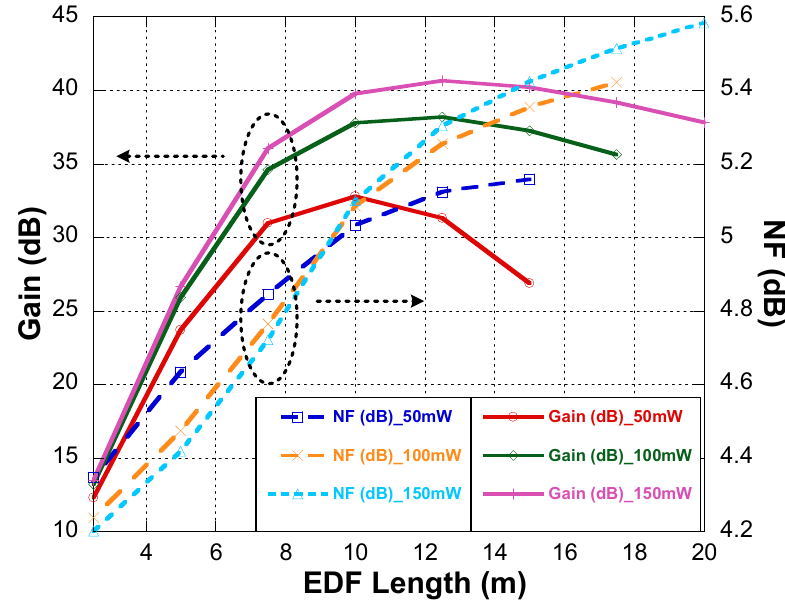
Figure 11. NF vs. EDF length and gain vs. EDF length at various pumping power values.